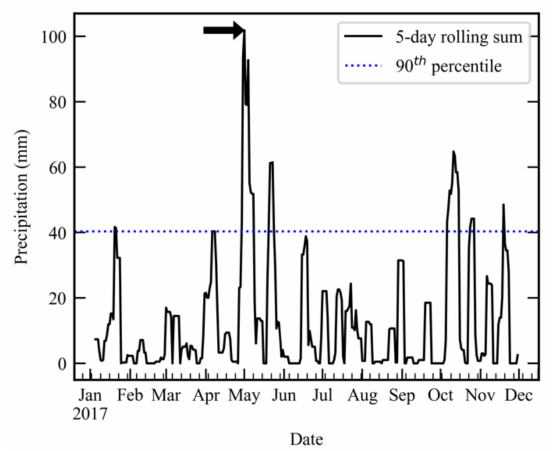
Figure 1. Five-day rolling sum of daily precipitation for the year of 2017 in Champaign County. The dashed line indicates the 90th-percentile value of these of rolling sums, and the arrow indicates the starting date used for the spatiotemporal analysis of ponding and dry down. Data source is the Midwestern Regional Climate Center cli-MATE database